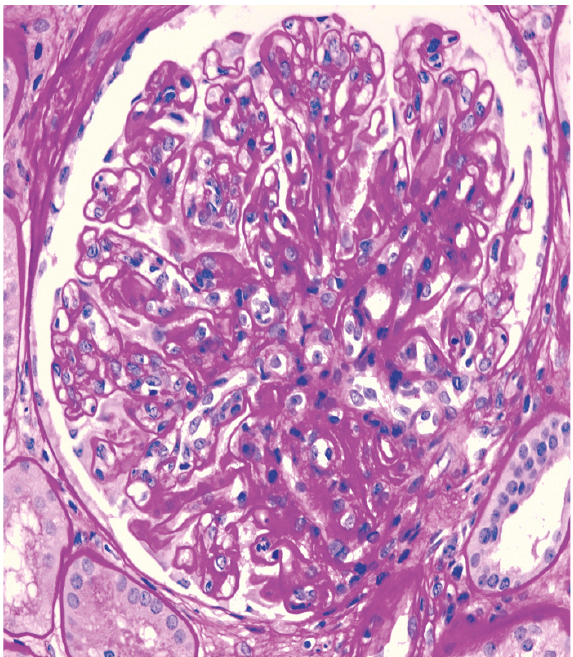
Figure 1: There is global moderate mesangial siderosis and hypercellularity (periodic acid-Schiff, x400).